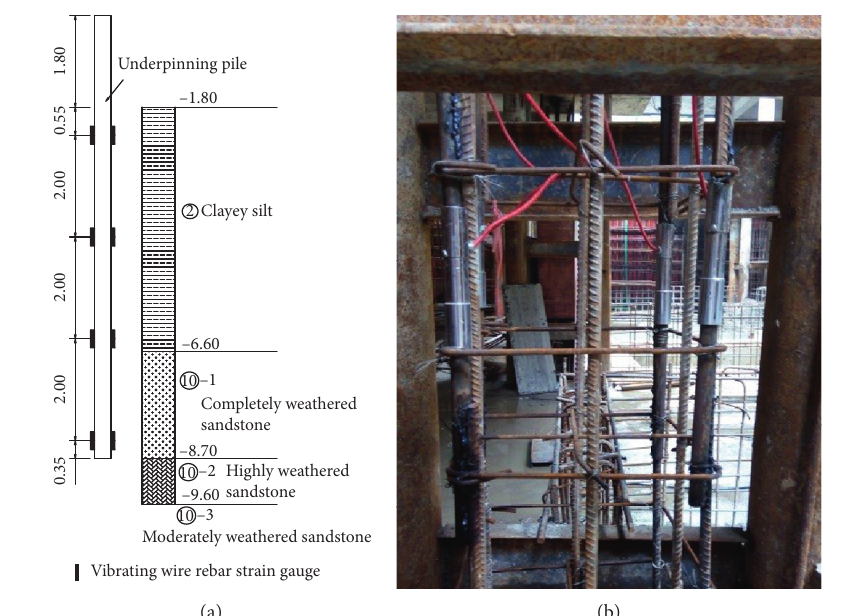
Figure 15: Layouts of vibrating wire rebar strain gauges in underpinning piles and structural pillars at the cap of 7C: (a) layout of vibrating wire rebar strain gauge in the pile; (b) layout of vibrating wire rebar strain gauges in the pillar.